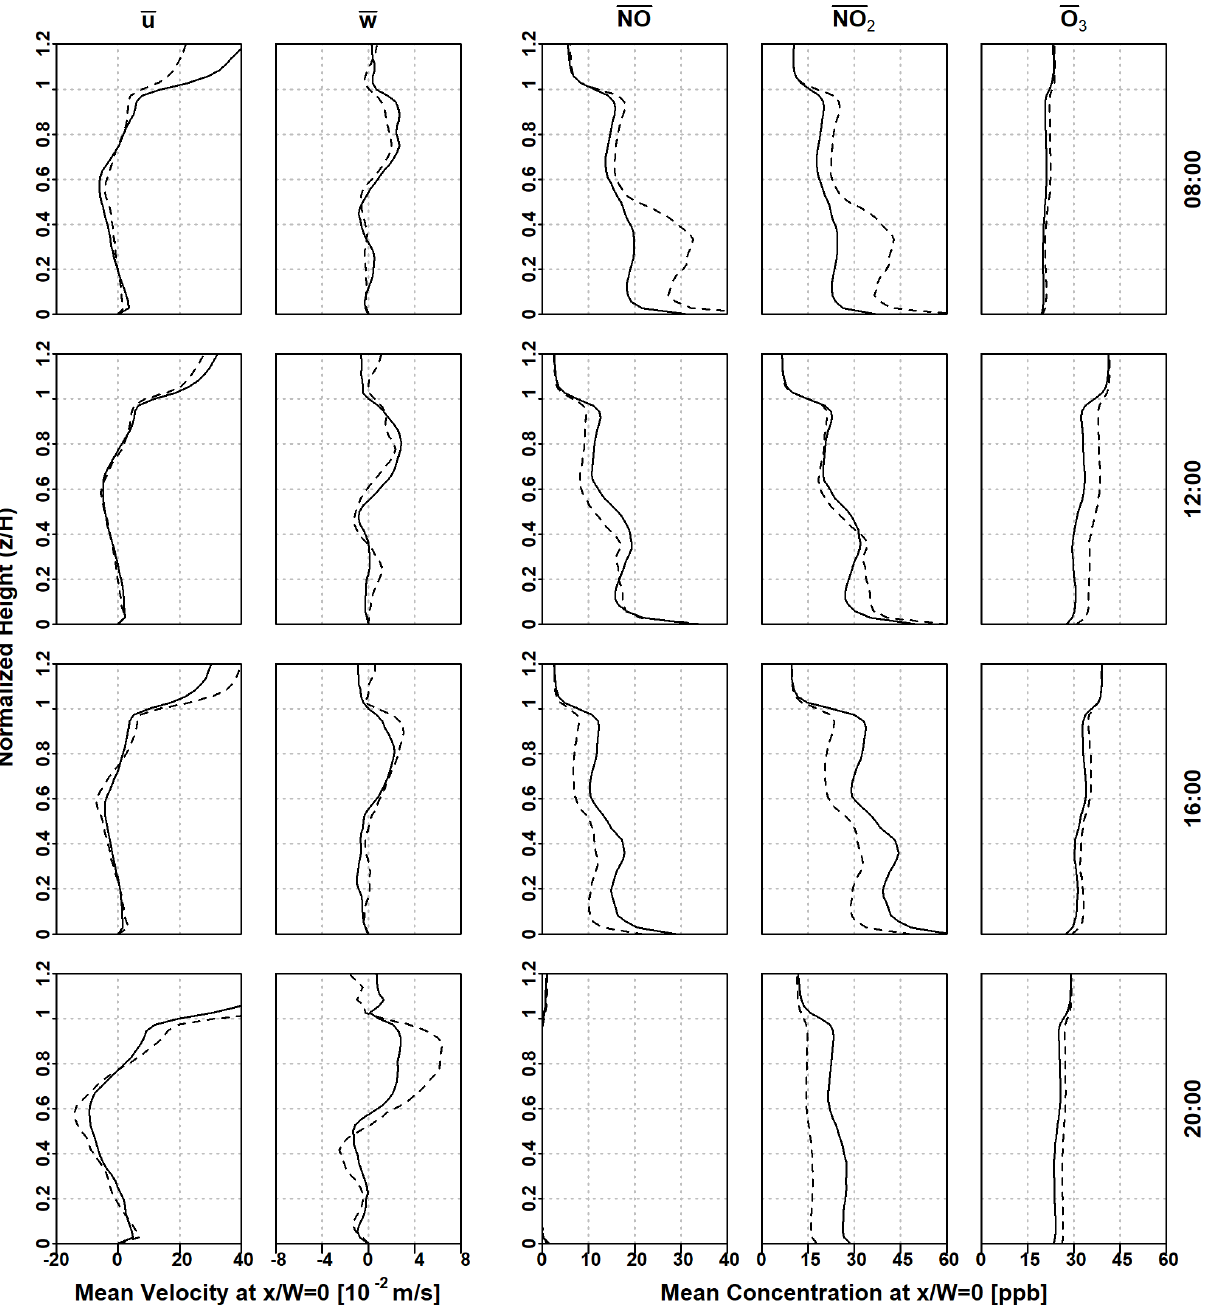
Figure 8. Comparison of vertical station profiles of mean velocity components and species concentrations for transient and stationary model runs at various points of time in UTC. Solid lines indicate transient runs, and dashed lines indicate stationary